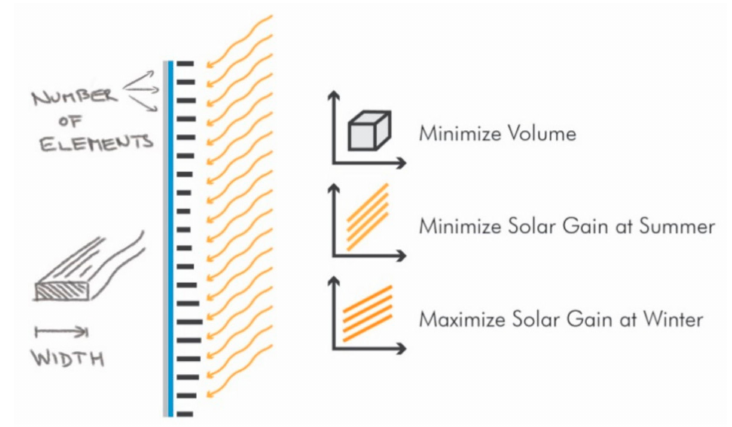
Figure 9. Design optimisation